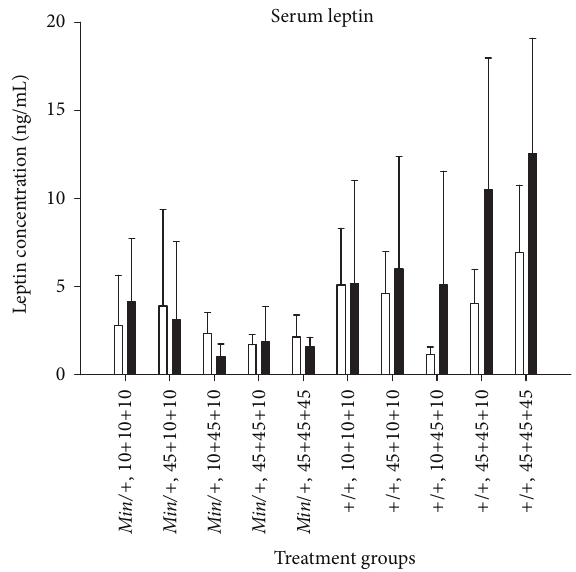
Figure 12: The concentration of leptin in serum at termination was measured in both Min/+ and wild-type (+/+) mice of both genders from all the dietary groups except 10+10+45 (see explanation in the legend to Figure 1), not treated with PhIP ( 𝑛 = 6 ). Females (white columns), males (black